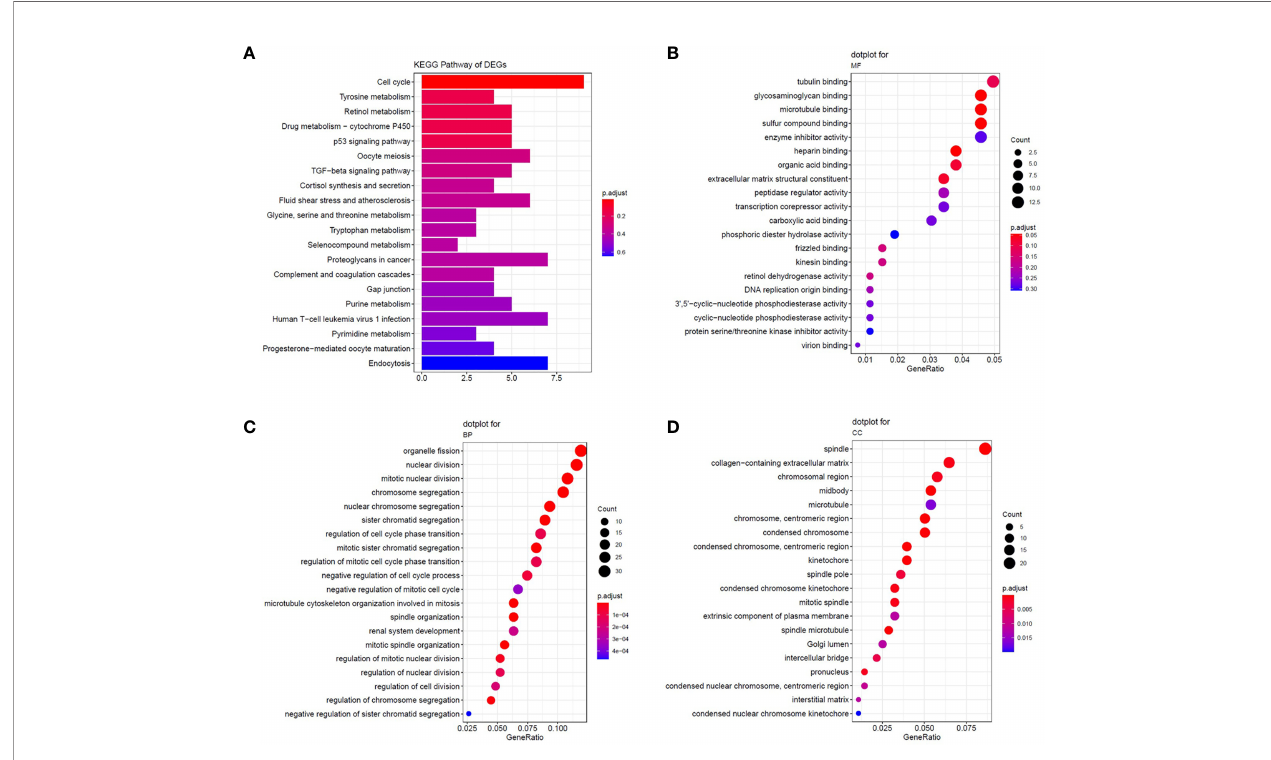
FIGURE 2 | The enrichment analysis of common DEGs. (A) Signi fi cantly enriched Kyoto Encyclopedia of Genes and Genomes (KEGG) pathways. (B – D) The results of GO enrichment for DEGs. Enrichment analysis of the common DEGs was assessed by the Metascape database separately. P-value < 0.05 was considered statistically signi fi